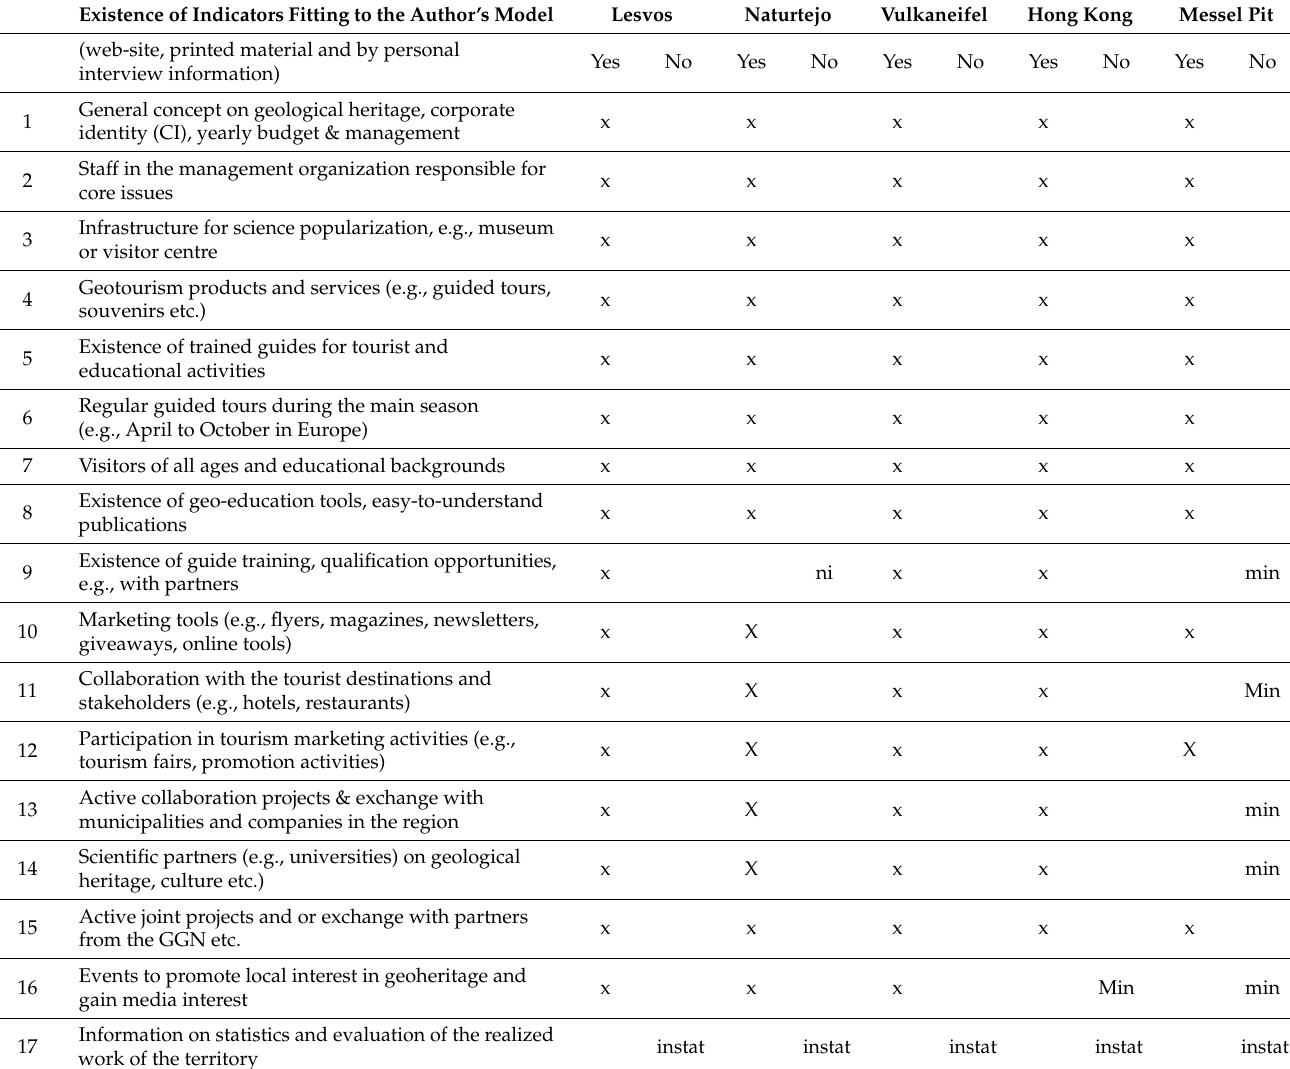
Table 1. Indicators on “Geotourism Mosaic Model by Frey [59]”. Examples from four UGGps and one WHS. Existence of Indicators Fitting to the Author’s